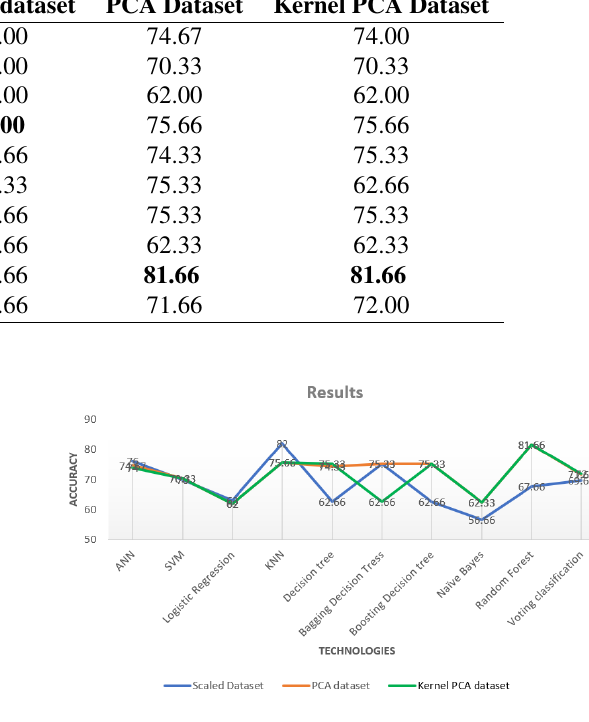
Figure 11. Technologies vs Accuracy %